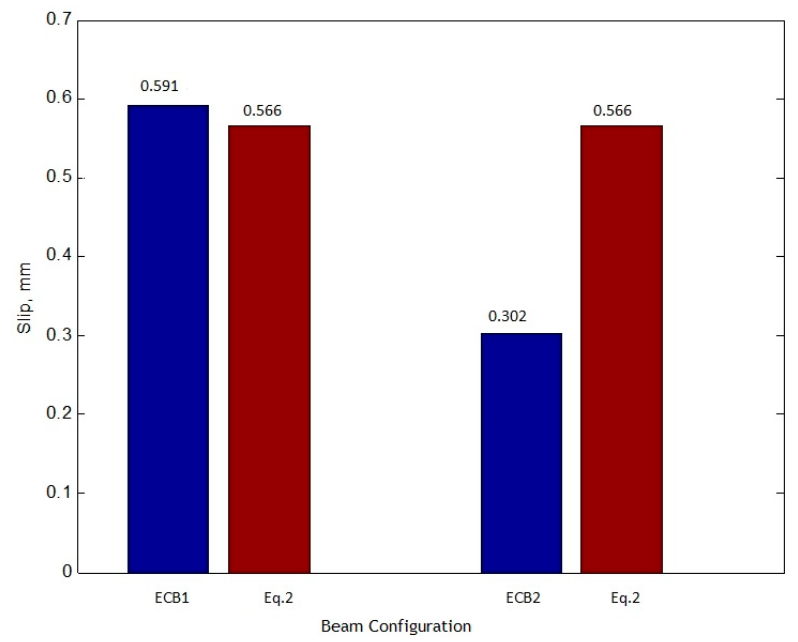
Figure 9. Comparison of proposed equation 2 with ECB1 and ECB2.